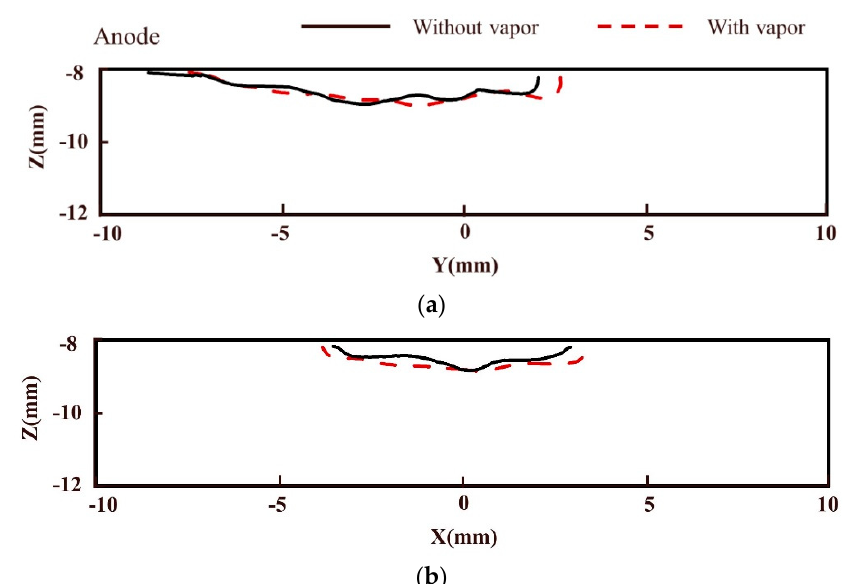
Figure 18. Influence of metal vapor on pool morphology: ( a ) yoz and ( b ) xoz planes.